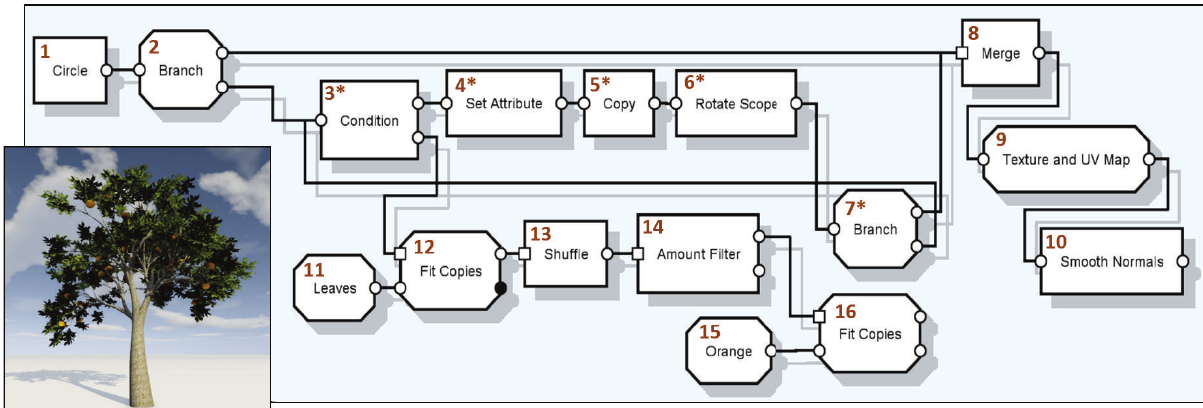
Figure 3: Orange fruit tree generated using a cyclic PCGR. The node numbering indicates the topological ordering of the nodes and the ones marked with an asterisk are bound to be executed multiple times, as they are found within a